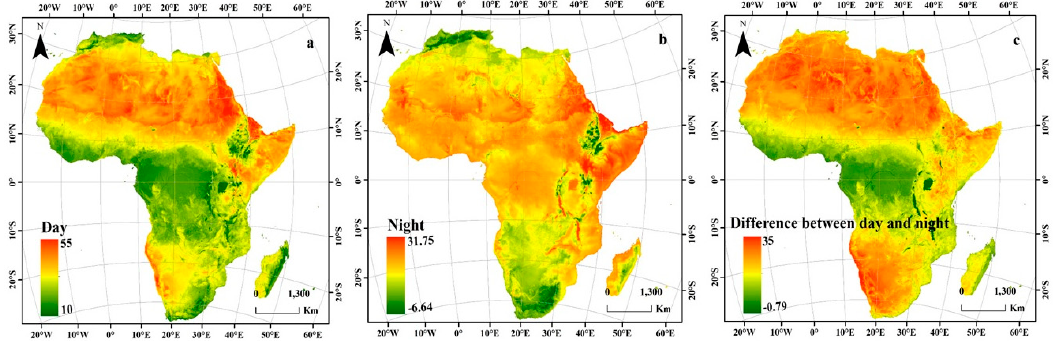
Figure 6. Spatiotemporal patterns in the average LSTs over Africa at ( a ) daytime, ( b ) nighttime, ( c ) and the difference between day and night LSTs.